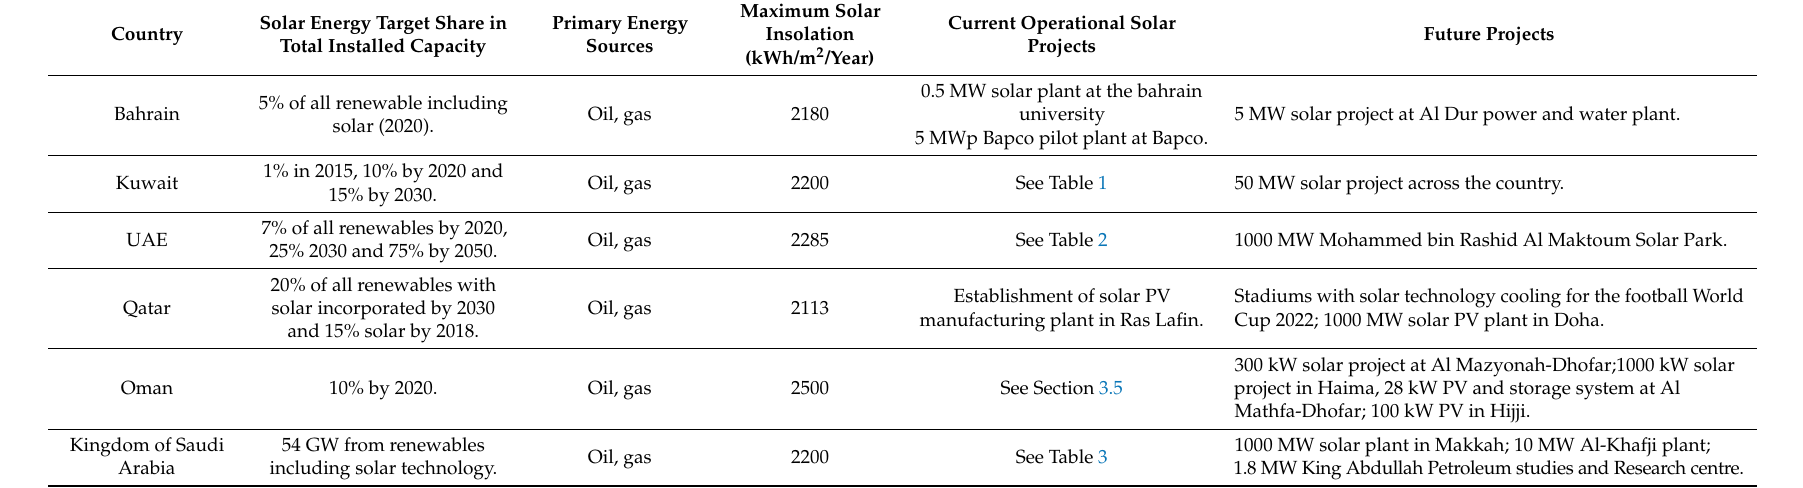
Table 7. Summary of solar PV development in the GCC